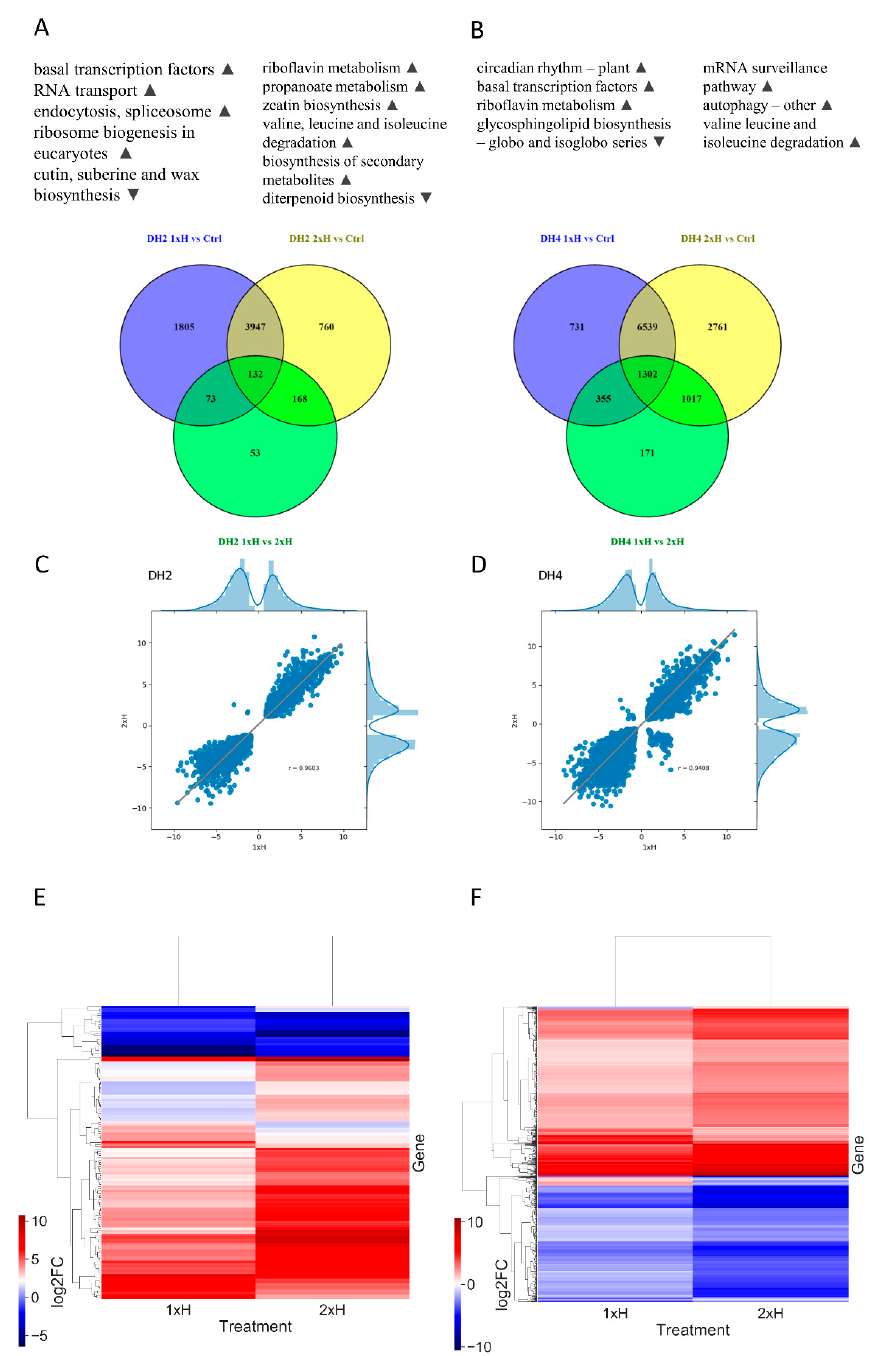
Figure 8. Number of differentially expressed genes (DEGs) specifically and commonly expressed in plants exposed to stress once (1xH) and twice (2xH) in the WL-T DH2 ( A ) and WL-S DH4 ( B ) accessions. Above the Venn diagrams, specific pathways for 1xH and 2xH treatment are listed. ▲ indicates up-regulation of pathway, ▼ indicates down-regulation of pathway. The correlation coefficient between 4079 and 7841 DEGs identified in plants treated once (1xH) and twice (2xH) in WL-T DH2 ( C ) and WL-S DH4 ( D ) is shown. Axes consist of Fold Change representing as ratio Treatment/Control. The heat map shows statistically significant DEGs commonly expressed in 1xH and 2xH in WL-T DH2 ( E ) and WL-S DH4 ( F